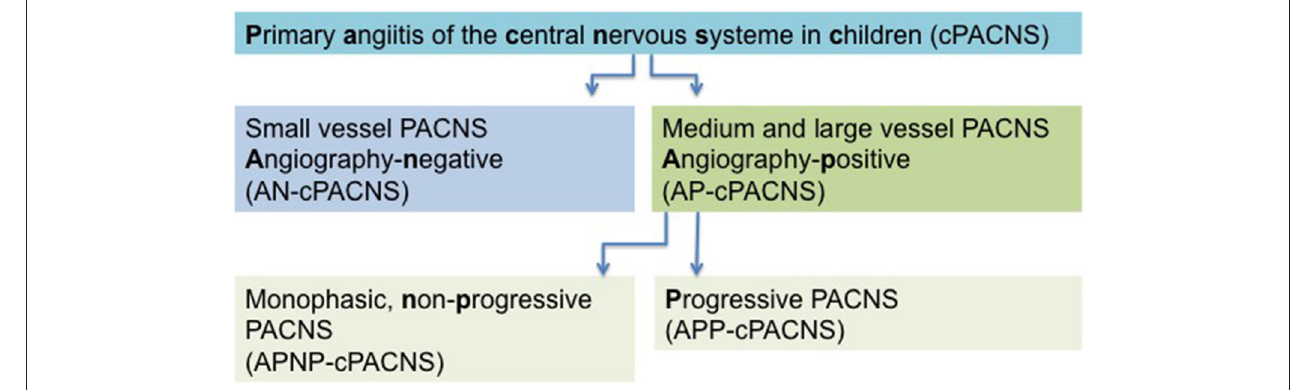
FIGURE 1 | Classification scheme in